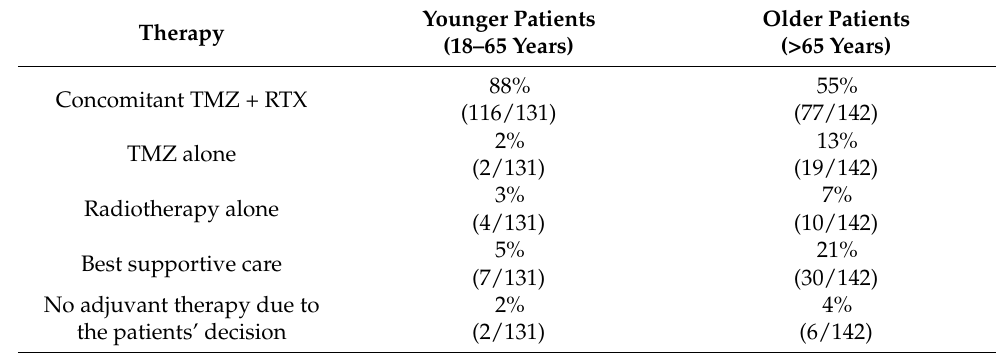
Table 1. Initiated adjuvant therapy for younger (18 to 65 years) and older patients (more than 65